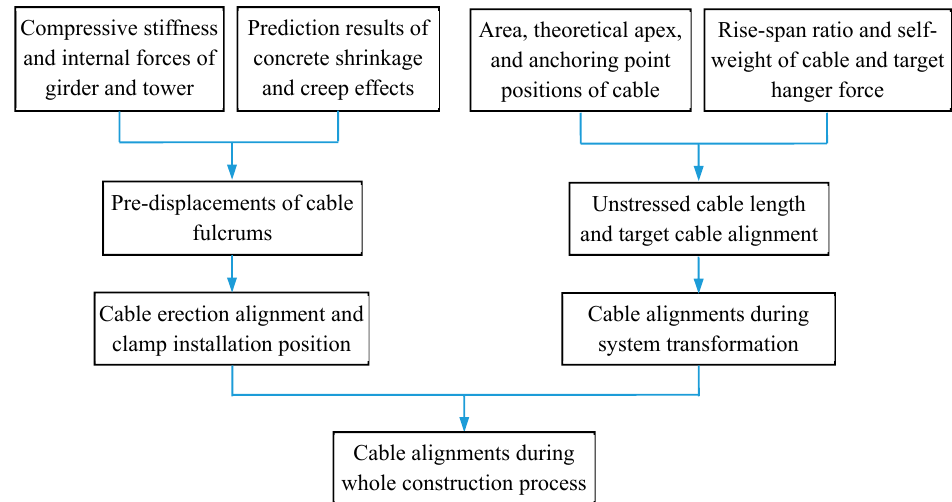
Figure 5. Numerical algorithm of the cable system for a concrete self-anchored suspension bridge.